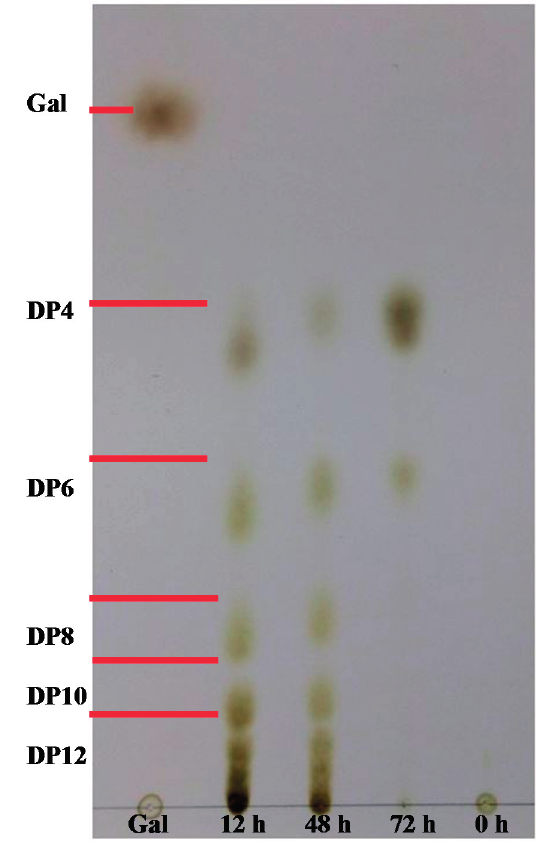
Figure 5. TLC chromatogram of the products at different time points of agarose hydrolysis by recombinant AgaA-FL. The sample was prepared by incubating recombinant AgaA with 0.3% ( w / v ) agarose at 40 °C for 72 h.